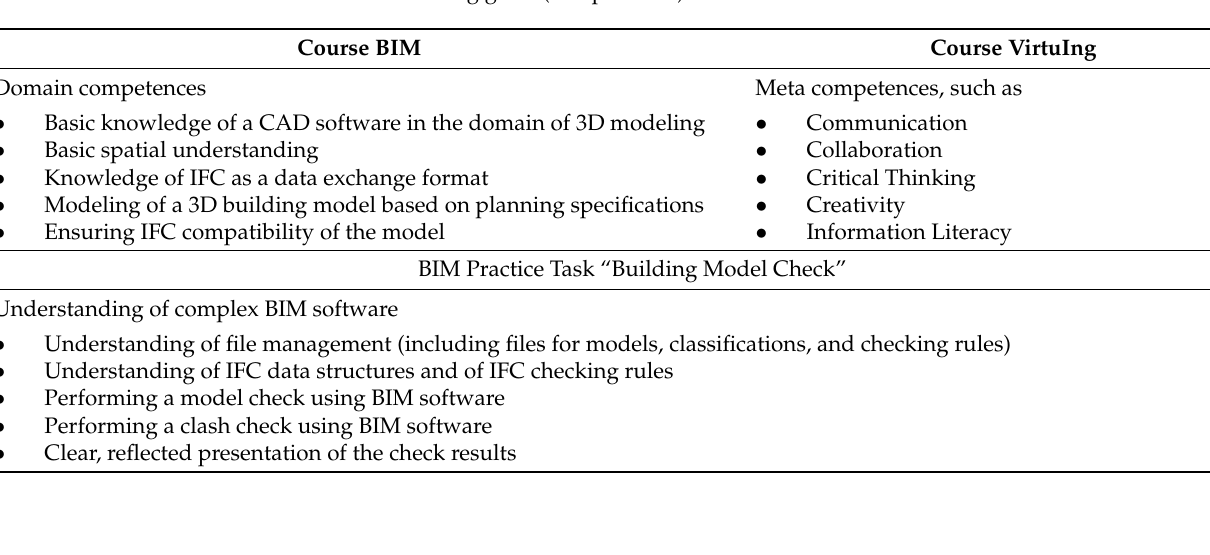
Table 1. Learning goals (competences) of the two